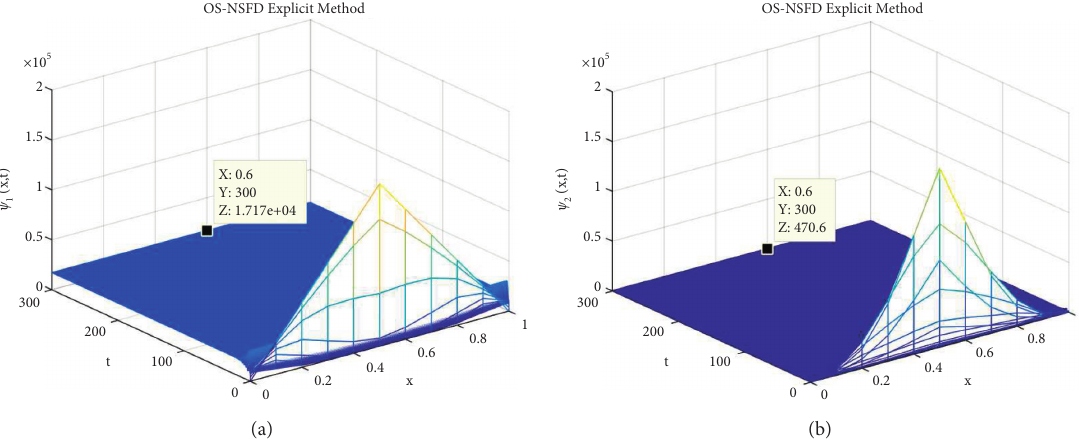
Figure 14: Solution graphs of ψ � λ � 0 . 05. (a) Solution graph of ψ κ � 0 . 1 , λ 1 2